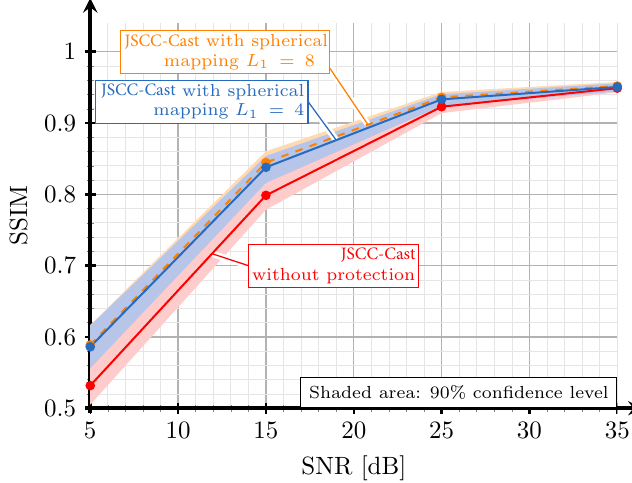
Figure 9. SSIM versus SNR obtained by JSCC-Cast considering three different redundancy strategies to protect the DC coefficients. The best combinations of 2D and 3D-DCT are used for a bandwidth ratio of 0.1. The red line corresponds to transmission without protection, the blue line to a spher- ical mapping with redundancy L 1 = 4, and the dashed orange line to a spherical mapping with redundancy L 1 =